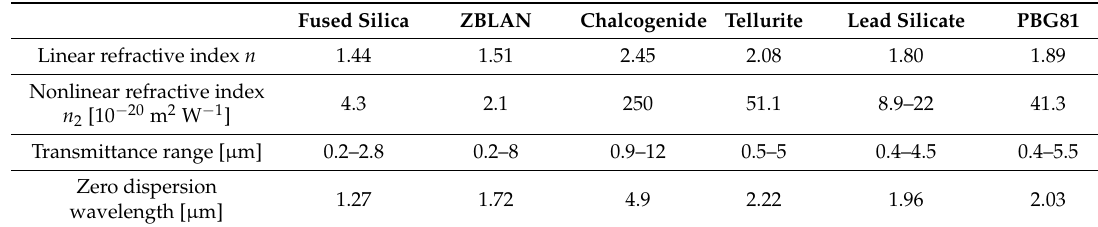
Table. 1. Properties of selected glasses used for development of PCFs [5,13,22–25]. Table 1. Properties of selected glasses used for development of PCFs [5,13,22–25].